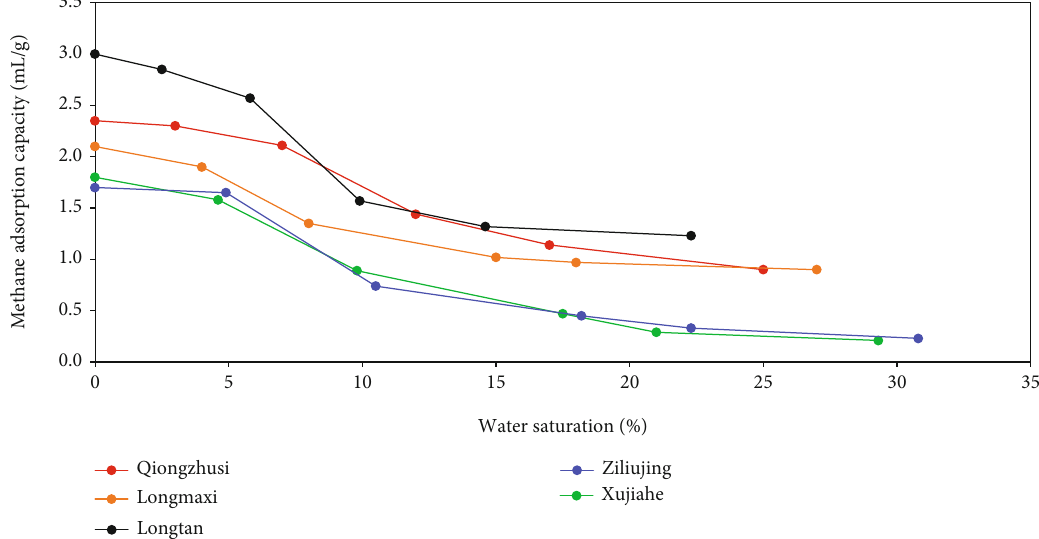
Figure 11: The in fl uence of water saturation of di ff erent types of shale on the methane adsorption